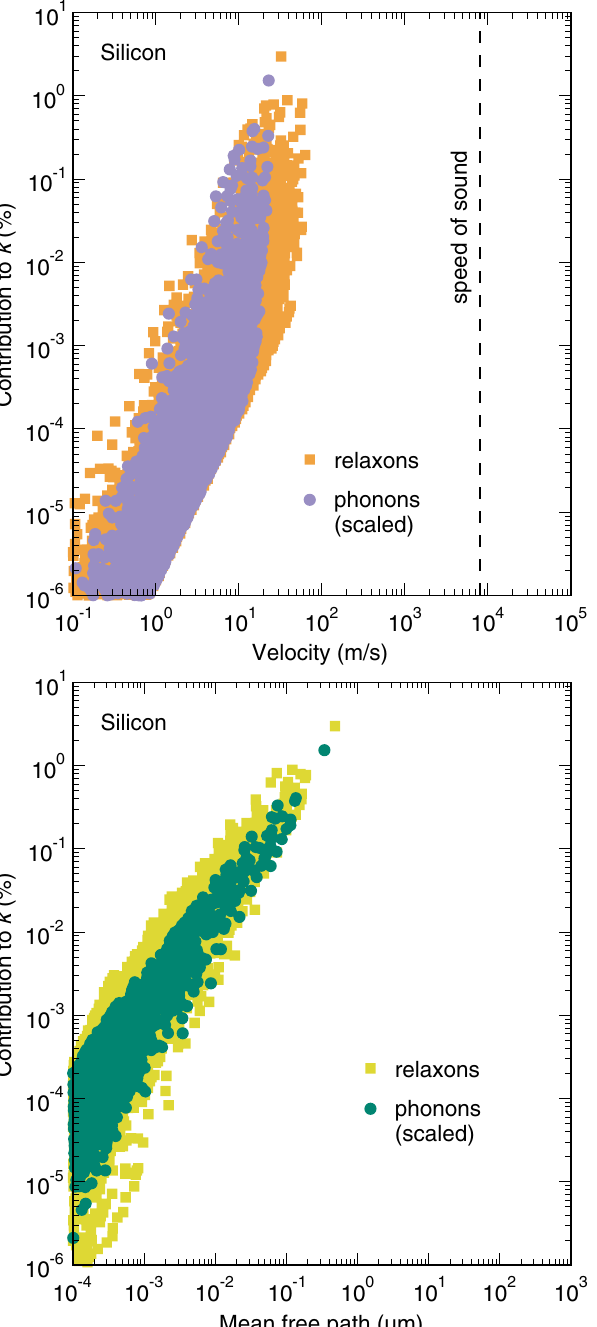
FIG. 11. Eigenvalues λ of the matrix A − 1 the definition), for graphene at room temperature, ordered by their magnitude. The red dots, roughly half of the eigenvalue spectrum, indicate eigenvalues j λ j > 1 that cause a divergence of the iterative solution for the Boltzmann transport equation. Most of the unstable eigenvalues are greater than 1, with only one eigenvalue lower than − 1